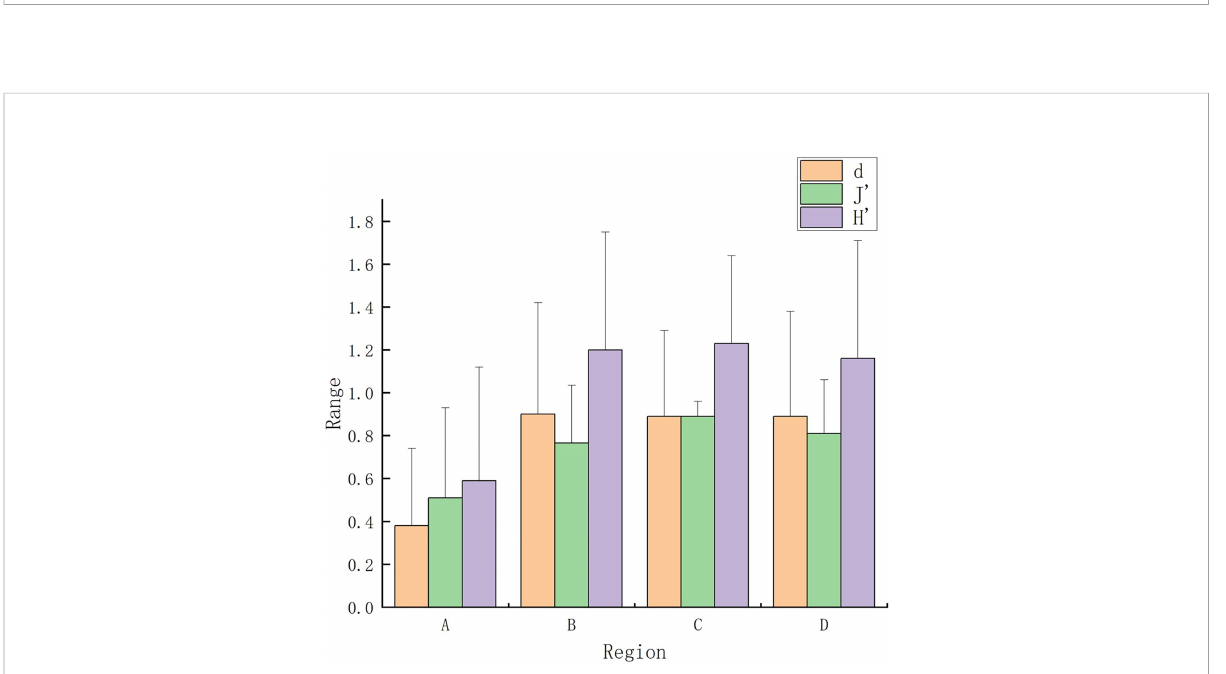
FIGURE 5 Margalef ’ s richness (d), Pielou ’ s evenness (J ′ ), and Shannon – Wiener diversity (H ′ ) indexes for macrobenthos communities in Hangzhou